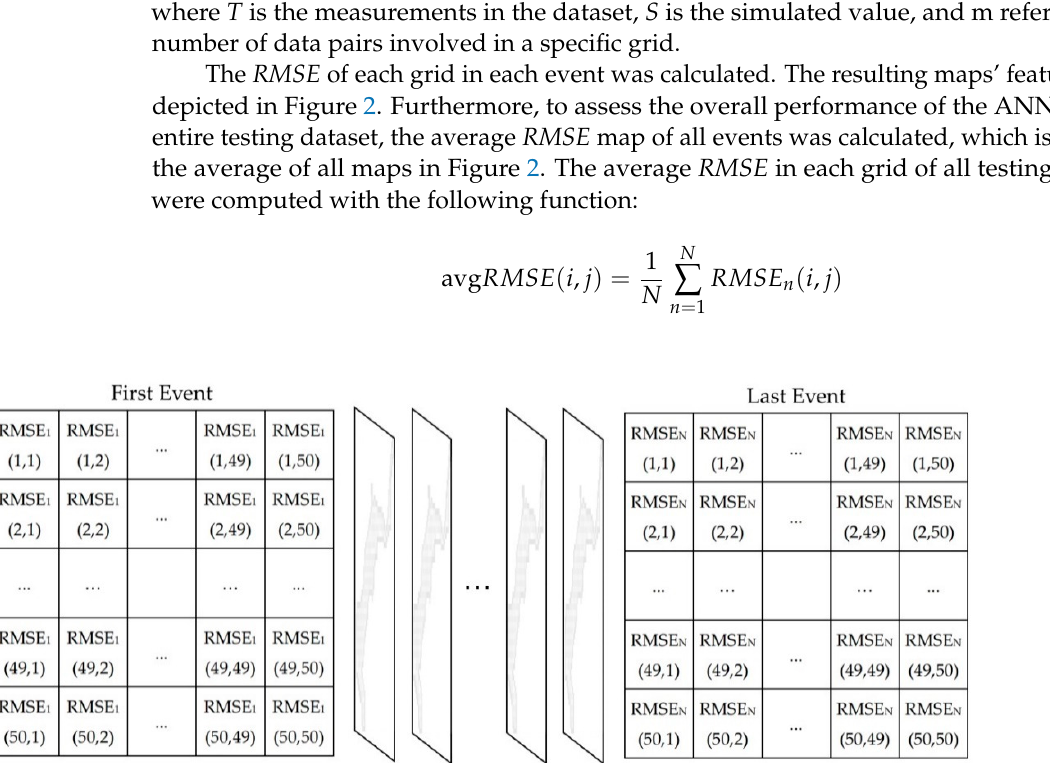
Figure 2. The RMSE maps for all the single events in the dataset. The RMSEn (i, j) is the RMSE value in the grid at i -th row and j -th column for the event number, n .